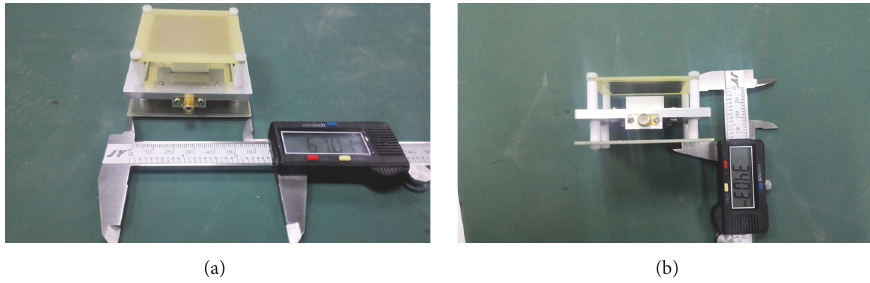
Figure 5: Photographs of the proposed DRA. (a) 3D view and (b) side